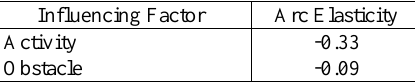
Table 9. Arc elasticity scenario